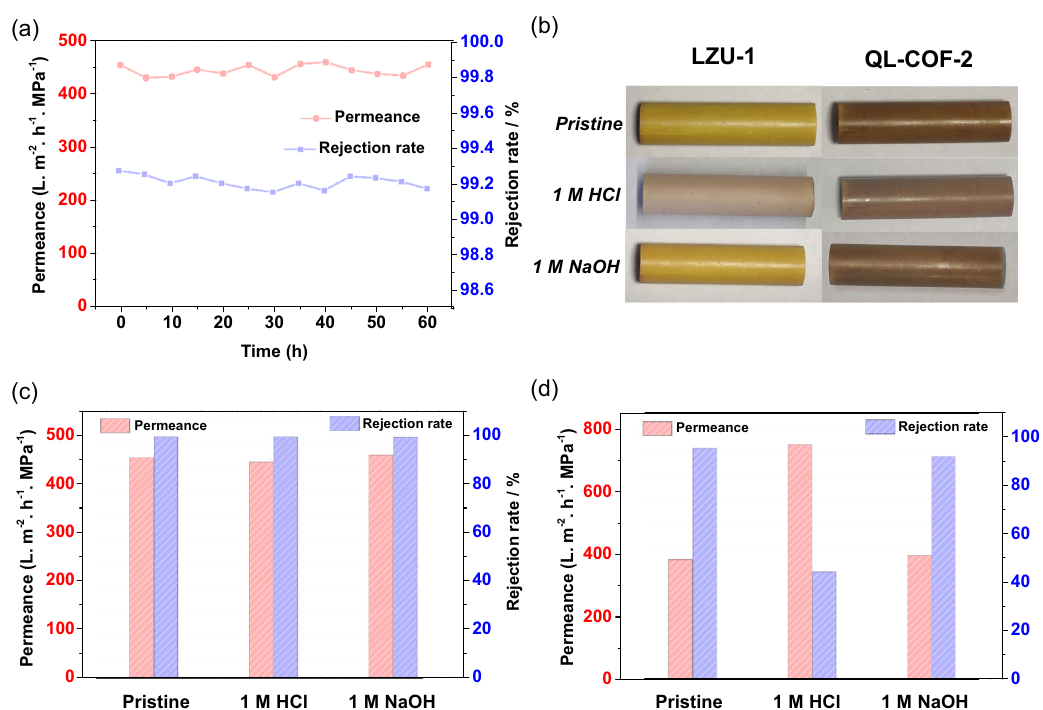
Fig. 4 Stability and durability of the QL-COF-2 and LZU-1 membranes. a Long-term stability of QL-COF-2 membranes under 50 ppm CR solutions. b The images of QL-COF-2 and LZU-1 membranes before and after treatment in 1 M HCl and 1 M NaOH. Nano fi ltration performance of QL-COF-2 ( c ) and LZU-1 ( d ) membranes under harsh treatment.